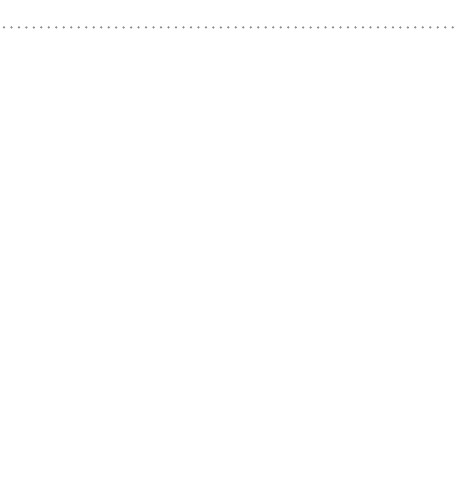
For codim-1 bifurcations, SubH and SupH respectively represent subcritical and supercritical Hopf bifurca- tions. SN iS and SN iU are the saddle-node bifurcation of equilibrium, where the superscript “S” (“U”) means that a stable (unstable) node collides with a saddle, and the subscript “i” is an integer to indicate the sequence of the appearance of this kind of bifurcation. SNIC is saddle-node on invariant circle bifurcation. BHom and SHom represent saddle homoclinic bifurcation, where “B” and “S” are used to distinguish the size of the saddle homo- clinic orbit. LPC is saddle-node (fold) bifurcation of the limit cycle. For codim-2 bifurcations, CP represents cusp bifurcations of equilibrium, GH is Bautin (degenerate Hopf) bifurcations of equilibrium, BT represents Bogdanov-Takens bifurcations of equilibrium, and SNHO is a saddle-node separatrix-loop.